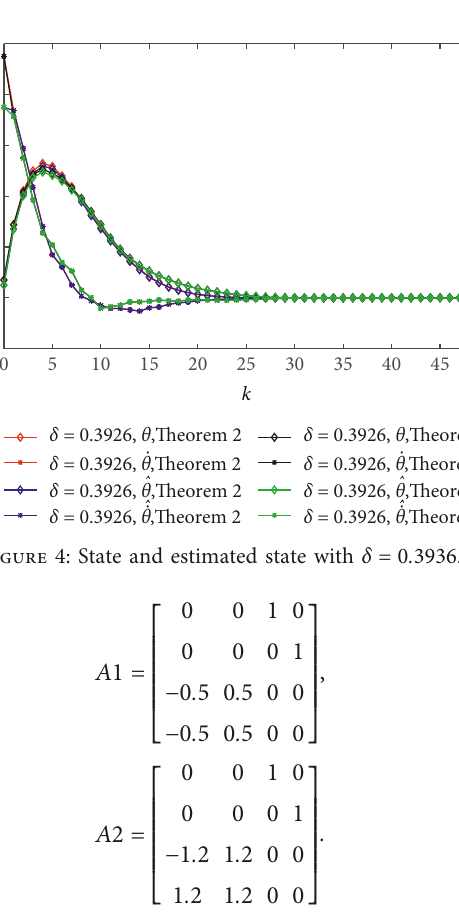
Figure 3: State and estimated state with δ � 0 . 6756.